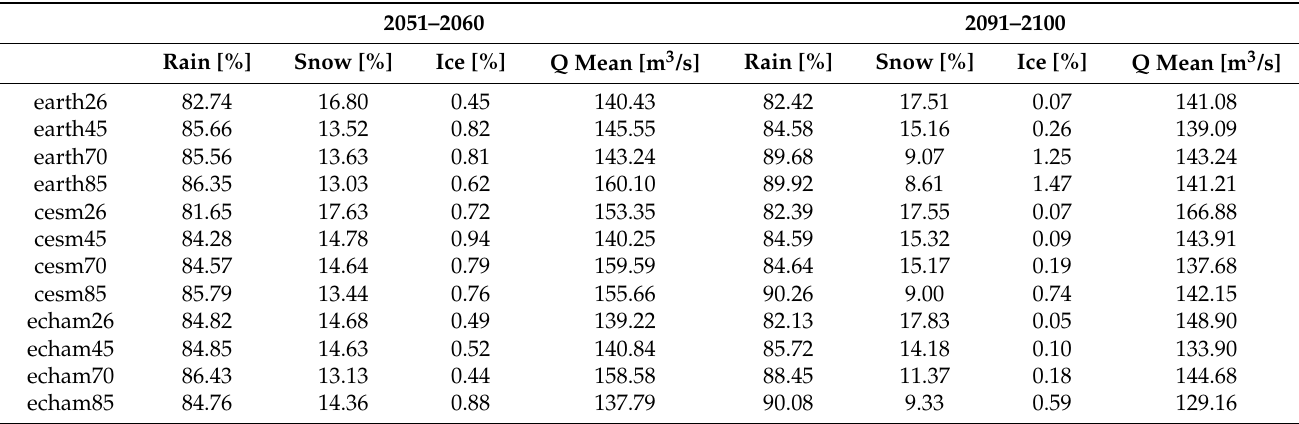
Table 4. Projected share of flow components for each GCM and each SSP.